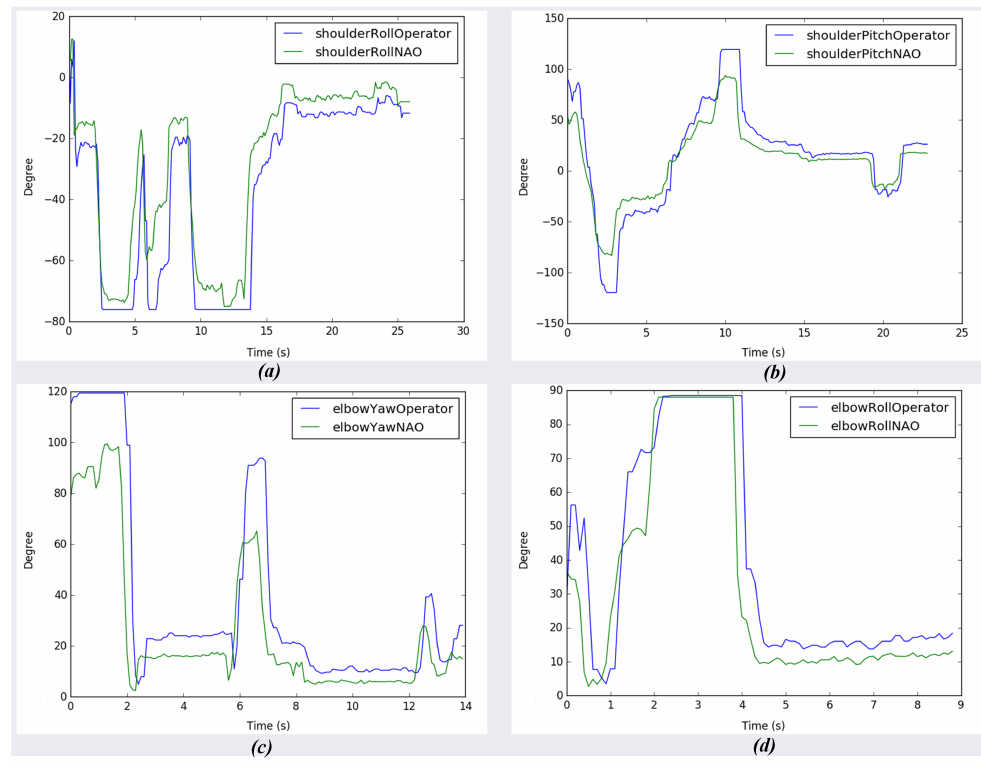
Figure 23. Result of upper limb following experiment for both human and NAO robot. ( a ) Shoulder